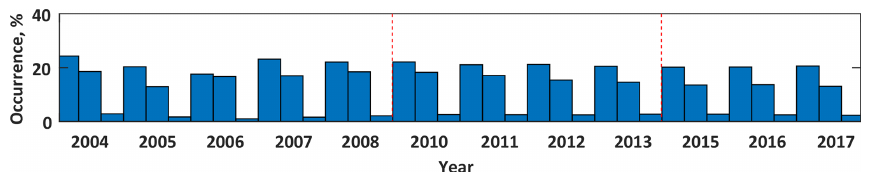
Figure 4. Occurrences of MSEs during each month of OSWIN observations. Blue bars show occurrences during June, July, and August of each year, with the maximum occurrence always in June. Red vertical dashed lines indicate the two missing years (2009 and